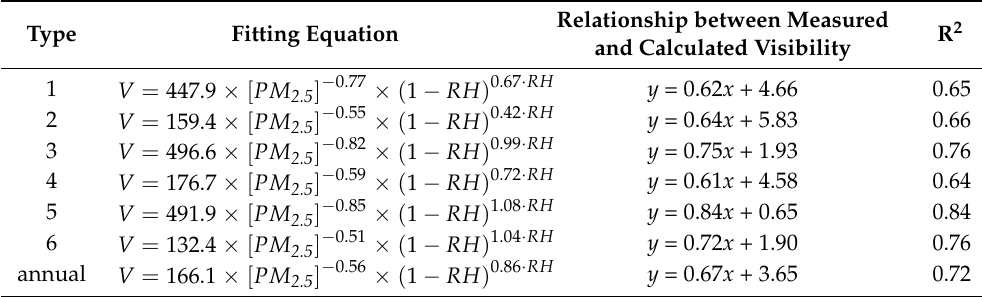
Relationship between